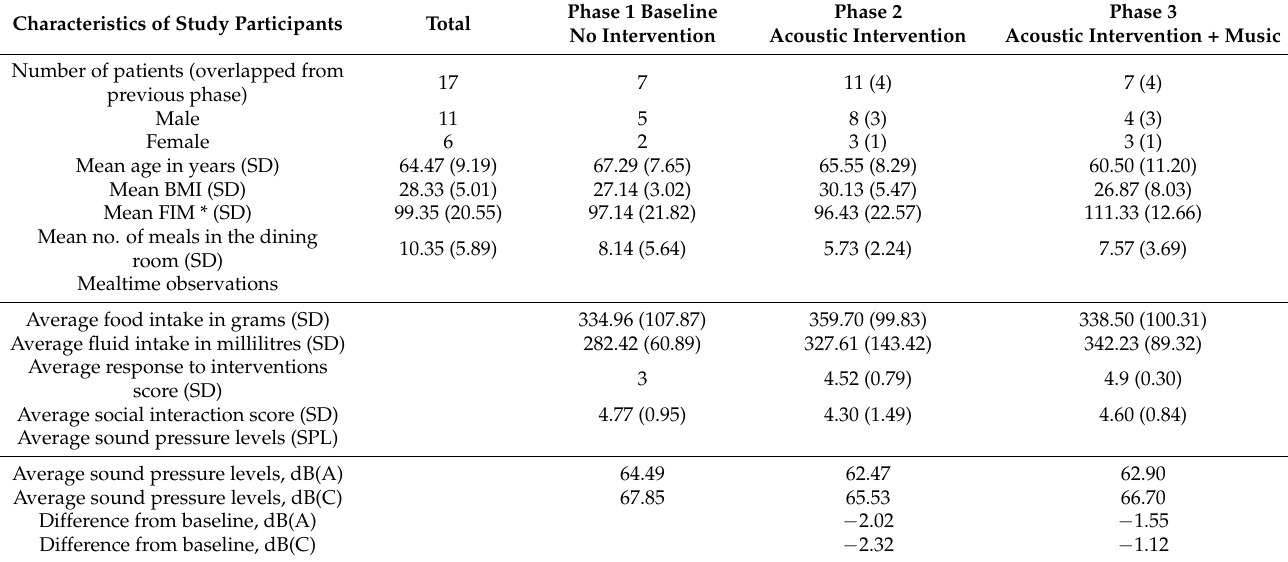
* FIM = Functional Independence Measure-scale: 18-item ordinal scale used to determine need of assistance of patients with diagnoses within rehabilitation populations. Scores range from 1 to 7. Scores are added for each item with total possible scores ranging from 18 (lowest possible) to 126 (highest possible) level of